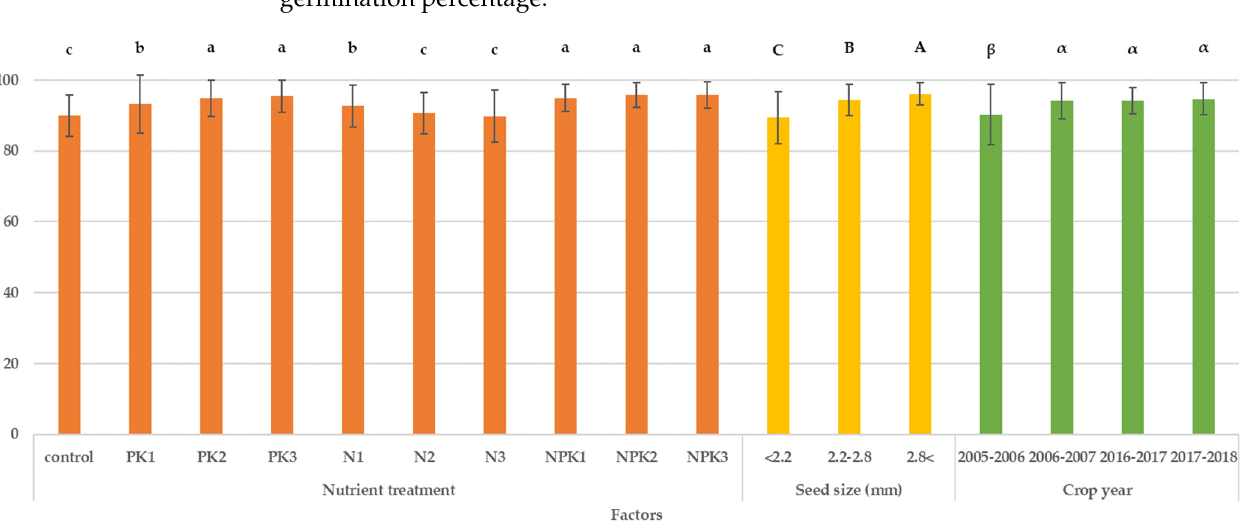
Figure 1. Effect of nutrient treatments, seed size and crop year on germination percentage of winter wheat. (Values marked with different letters are significantly different at the p < 0.05 significance level. Small letters (a–c) represent nutrient treatments, capital letters (A–C) represent seed sizes and Greek letters ( α , β ) represent years, where the order of the letters starts from the largest value. The standard deviation (SD) has been marked in the columns.)